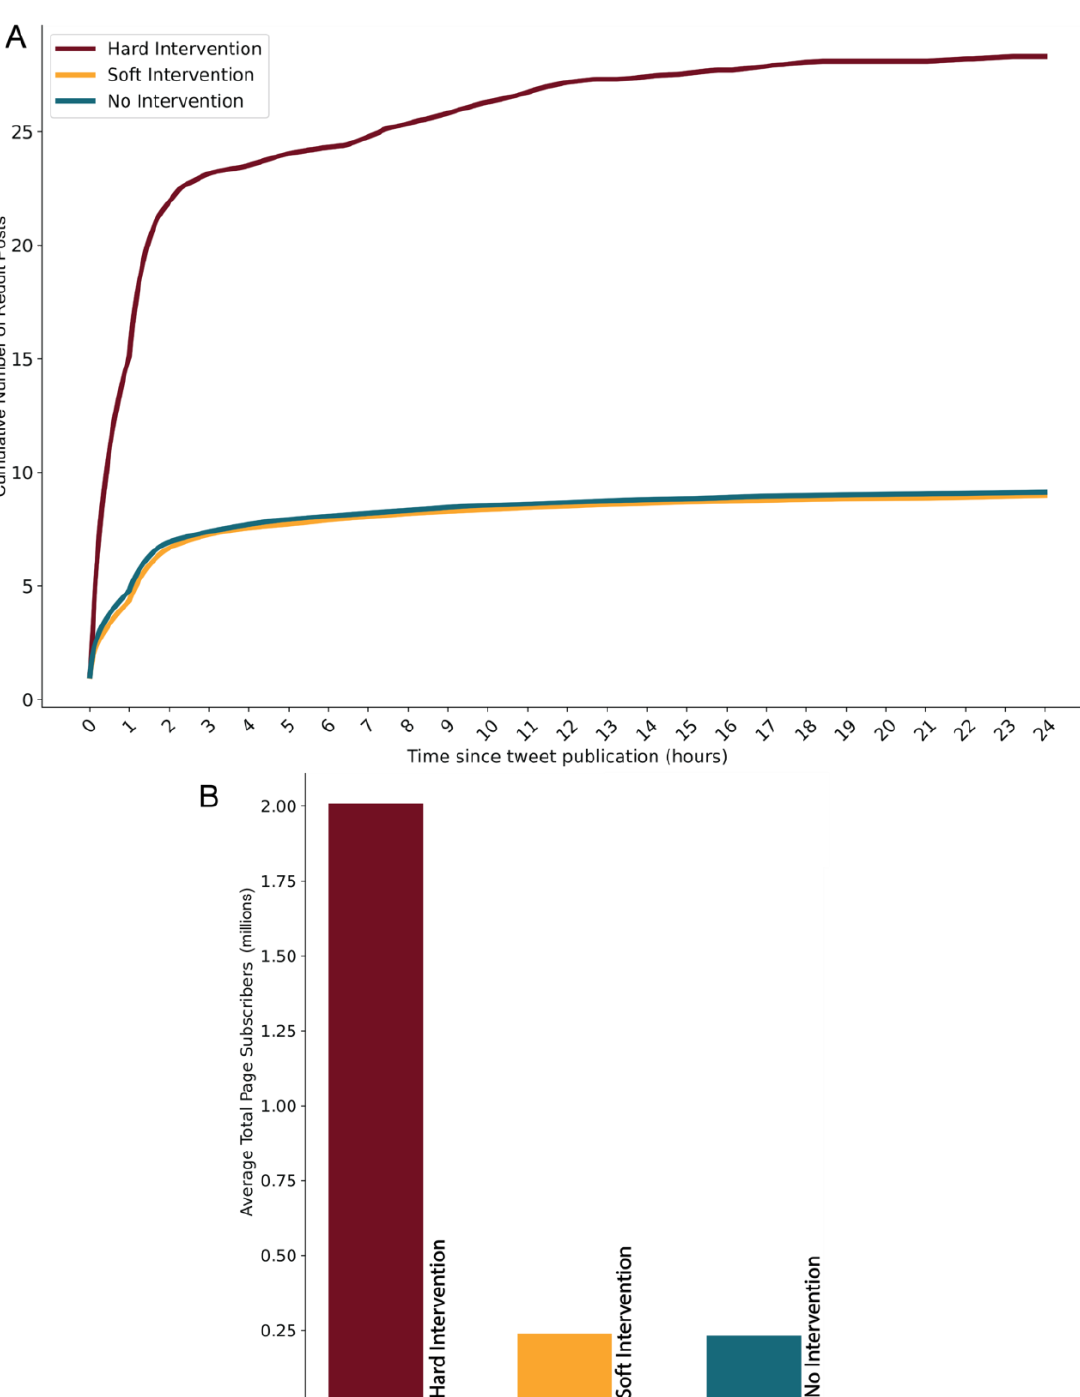
Figure 5. Trajectory and exposure of tweets on Reddit by intervention type. We first group all messages by the type of intervention they received on Twitter (hard intervention, soft intervention, or no intervention). (a) Growth of Reddit posts by intervention: we plot the cumulative number of posts (y-axis) over time (x-axis) averaged over all of the messages in each category. (b) Exposure per tweet on Reddit by intervention on Twitter: we measure the average number of subreddit subscribers for subreddits that contained the messages in each